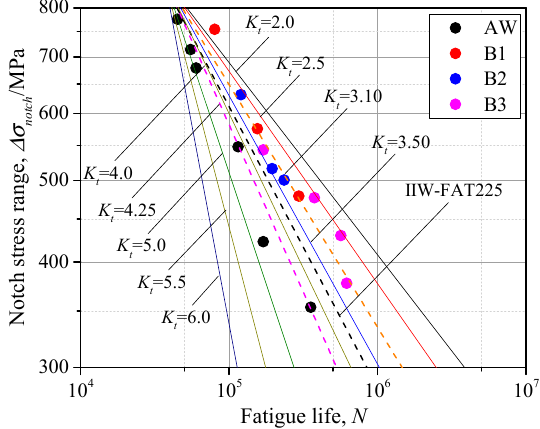
Figure 14. The S - N curve considering SCF.